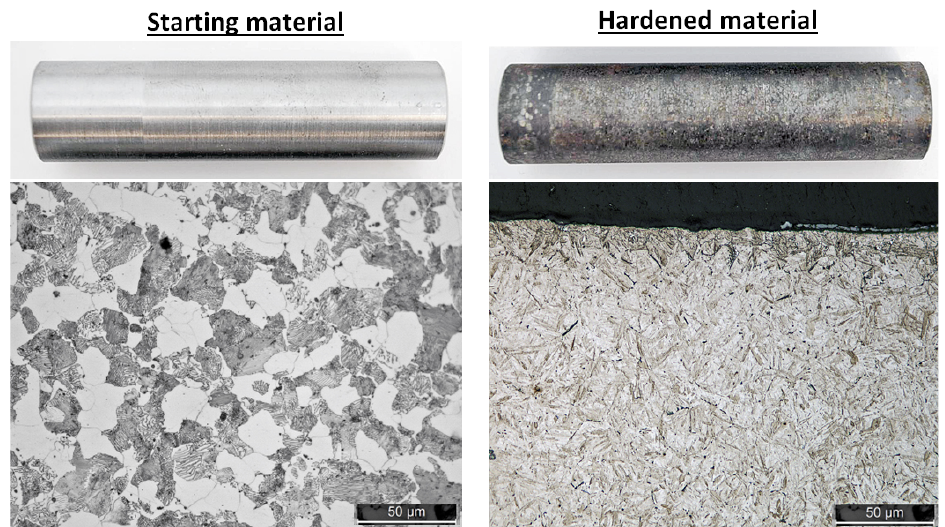
Figure 1. Overview of surfaces and microstructures before and after induction hardening. Table 1. Induction hardening settings of the two test sets, set A and B.